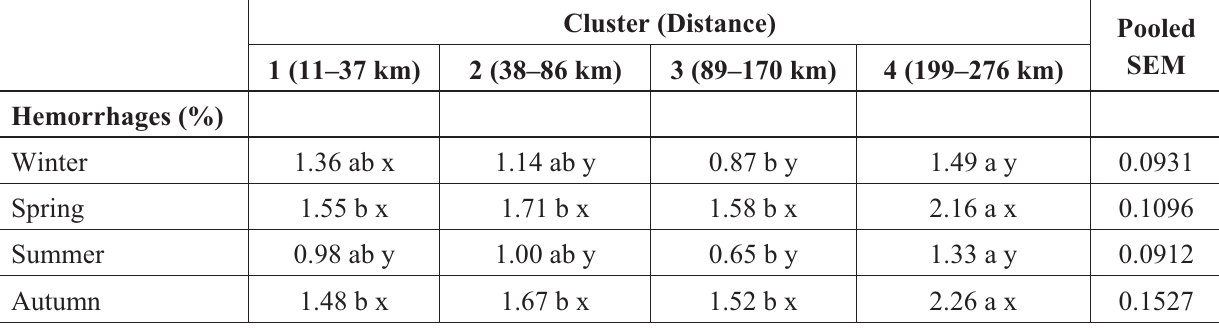
Table 5. Effect of interaction between distance and season on the incidence of hemorrhages. Cluster (Distance)